Question: Summarize what this figure shows in one sentence.
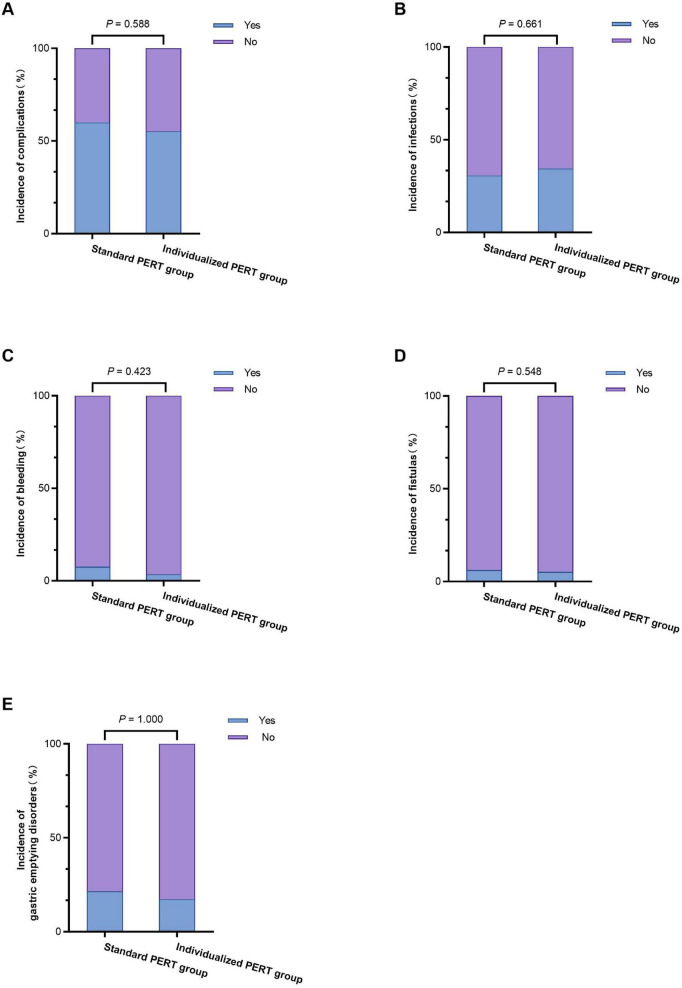
Answer: Postoperative complications in the two groups. (A) Overall incidence of postoperative complications; (B) incidence of infectious complications; (C) incidence of bleeding; (D) incidence of fistulas; (E) incidence of gastric emptying disorders.